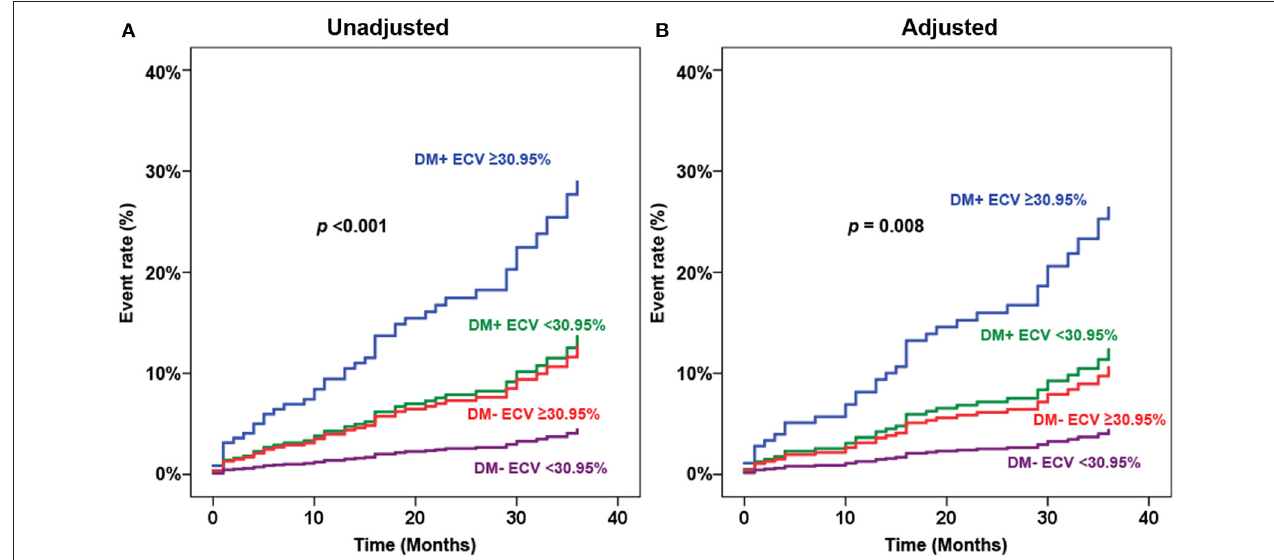
FIGURE 5 | Extracellular volume fraction (ECV) mapping of patients with type 2 diabetes (T2D) and high ECV (A) , T2D and lower ECV (B) , high ECV without T2D (C) , and lower ECV without T2D (D) .